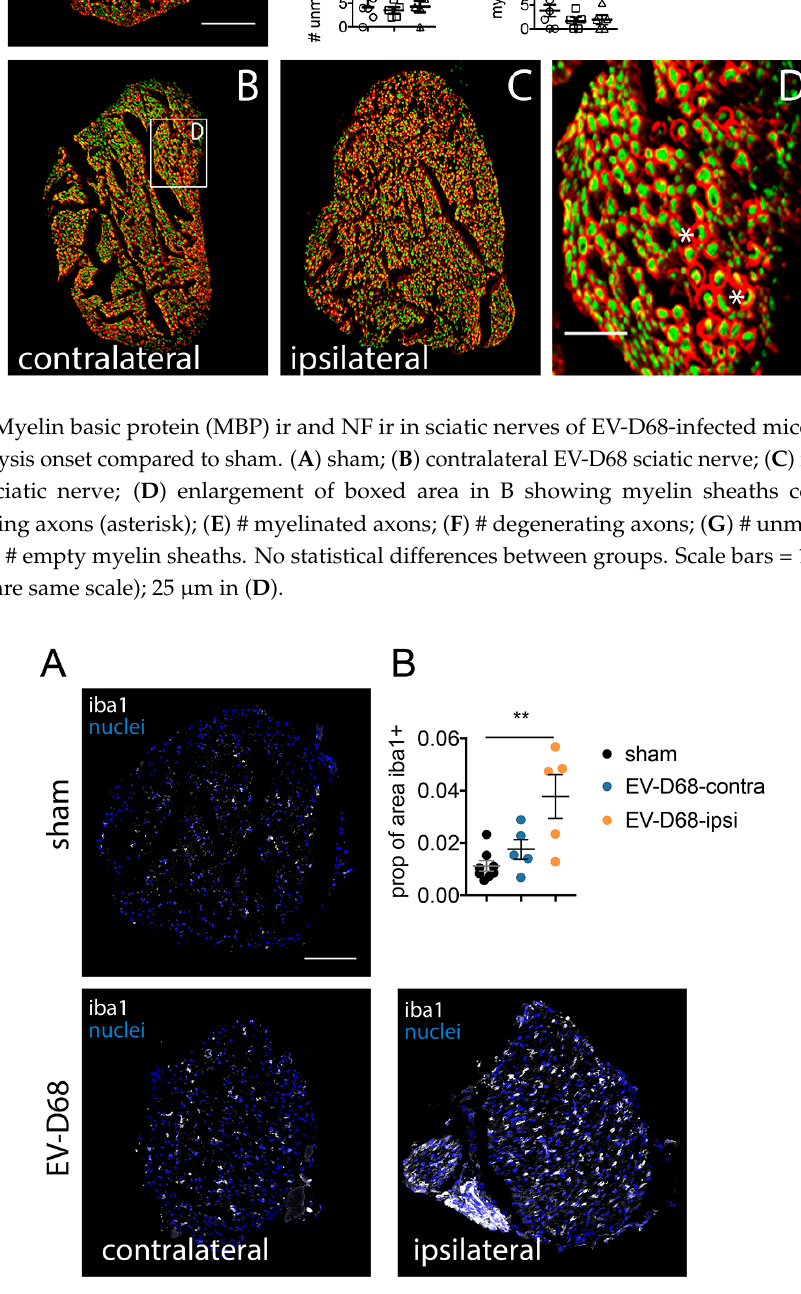
Figure 8. Increased macrophage/microglial iba1 ir in sciatic nerves of EV-D68-infected mice six weeks after paralysis onset compared to sham. ( A ) Iba1 ir in coronal cross-sections of sciatic nerves (100 µm bar); ( B ) Quantification of iba1 ir. ** p < 0.01 using one-way analysis of variance.